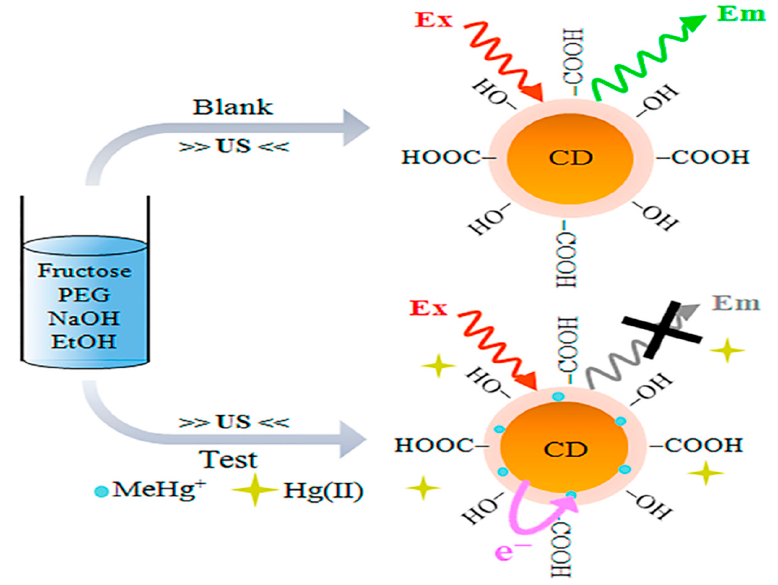
Figure 6. Scheme for illustrating the process of sensing methylmercury with the use of CQDs as probe (Adapted from the Ref. [184] with the permission of ACS).